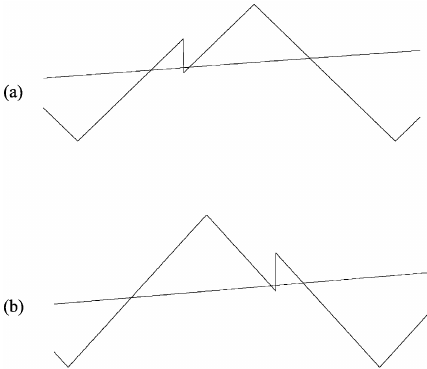
Figure 2. Illustration of the cases that the reference crosses the carrier four times in a cycle of the carries after a negative phase shift of the carriers: ( a ) Positive phase shift; ( b ) Negative phase shift.